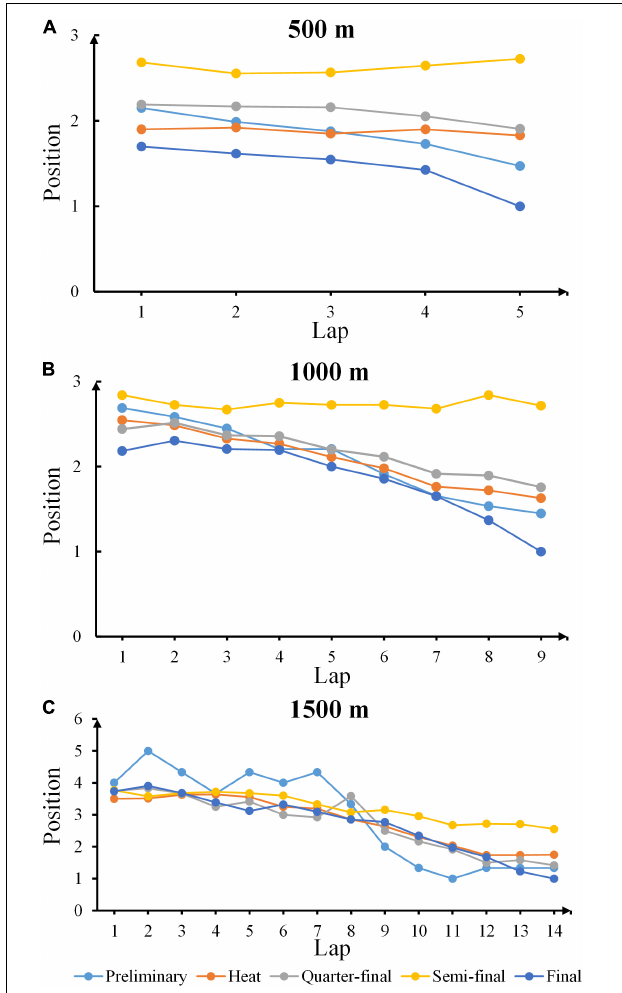
FIGURE 3 | Pacing patterns in each round for champions. (A–C) The pacing patterns for champions during each round in 500, 1,000, and 1,500 m short track speed skating competitions. The light blue, orange, gray, yellow, and dark blue stand for preliminary, heat, quarterfinal, semi-final, and final rounds,